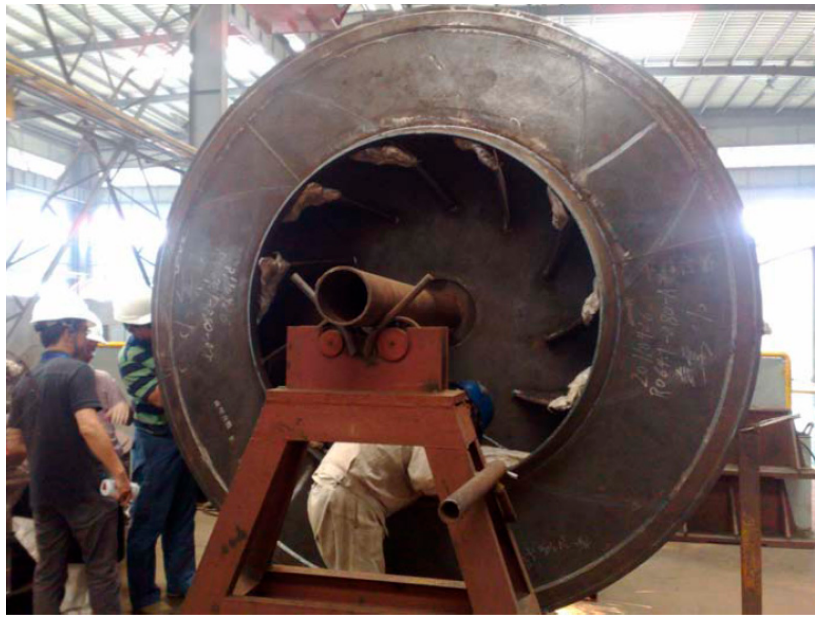
Figure 16. Photograph of the centrifugal compressor with a fully developed blade crack.